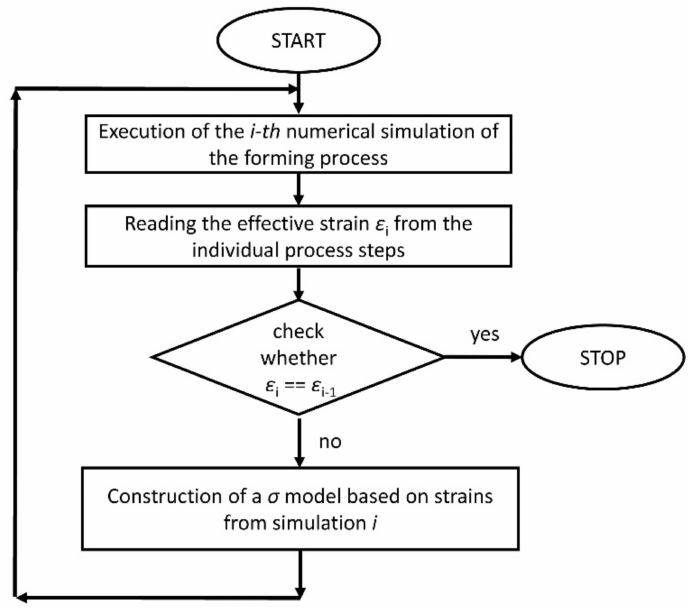
Figure 7. Scheme of the fitting algorithm for determining the parameters of the flow stress model.